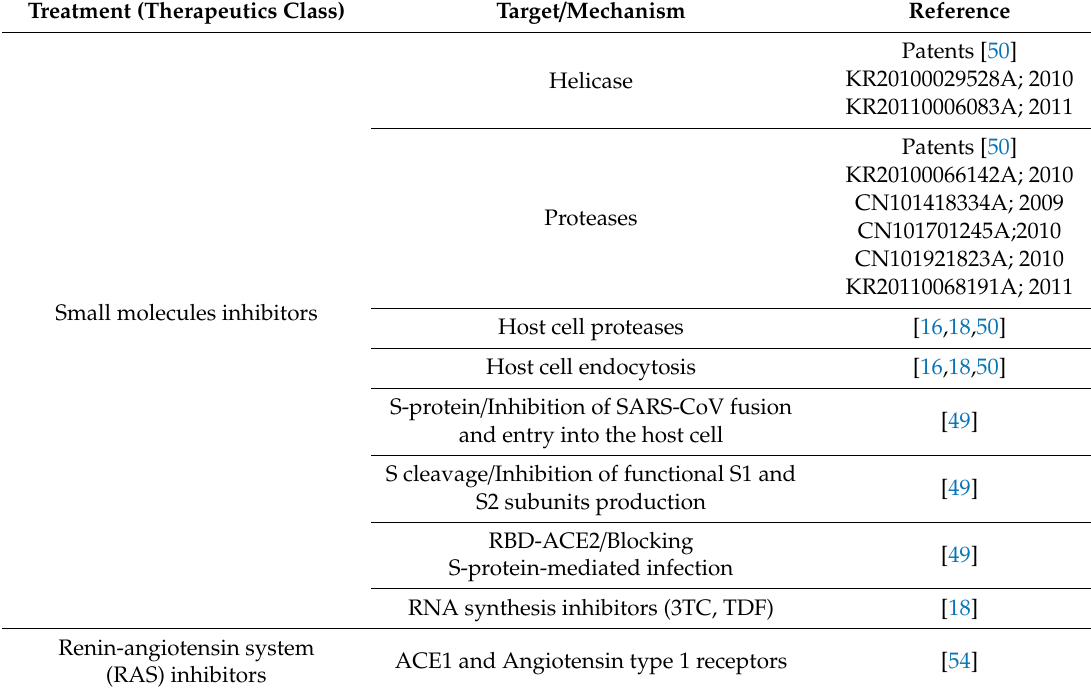
Table 1. Present Coronavirus (CoV) drug treatment